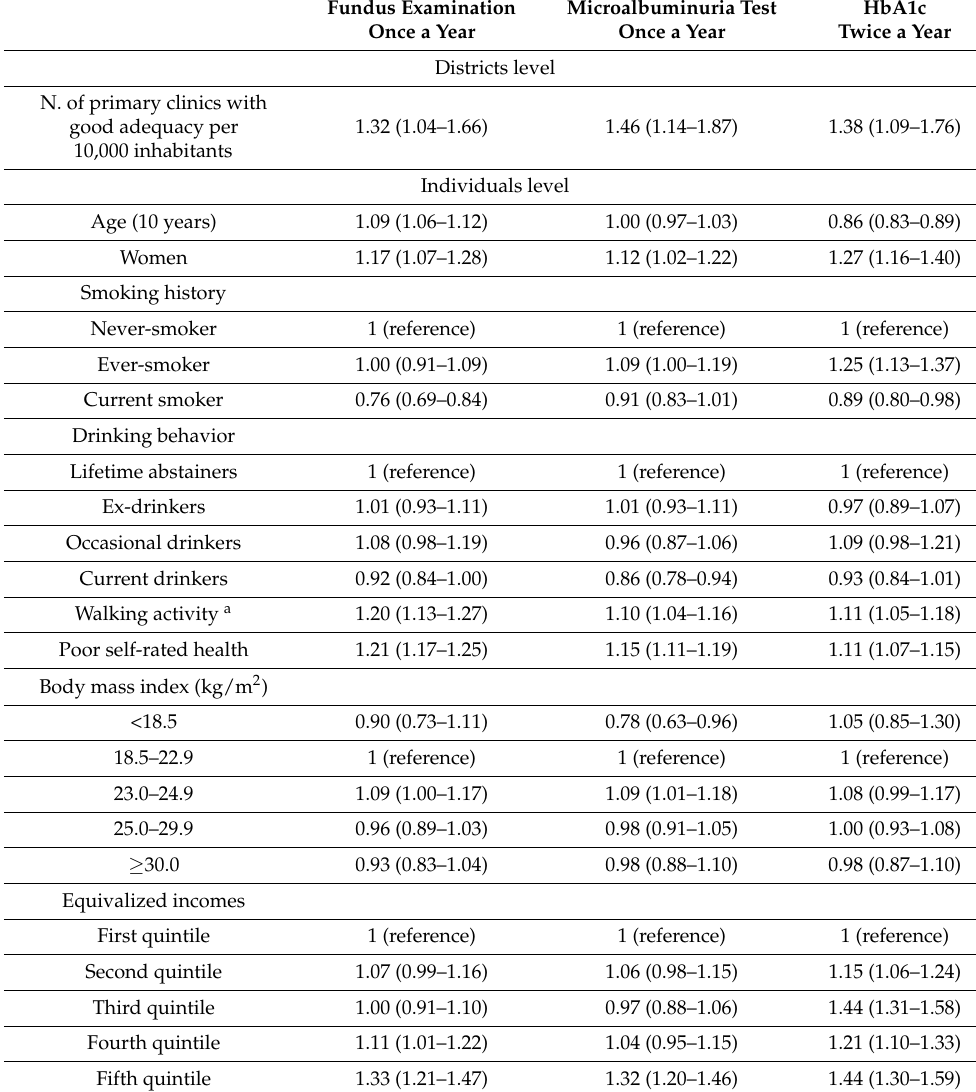
Table 3. Multilevel multivariate logistic regression for taking diabetes complication test in diabetes